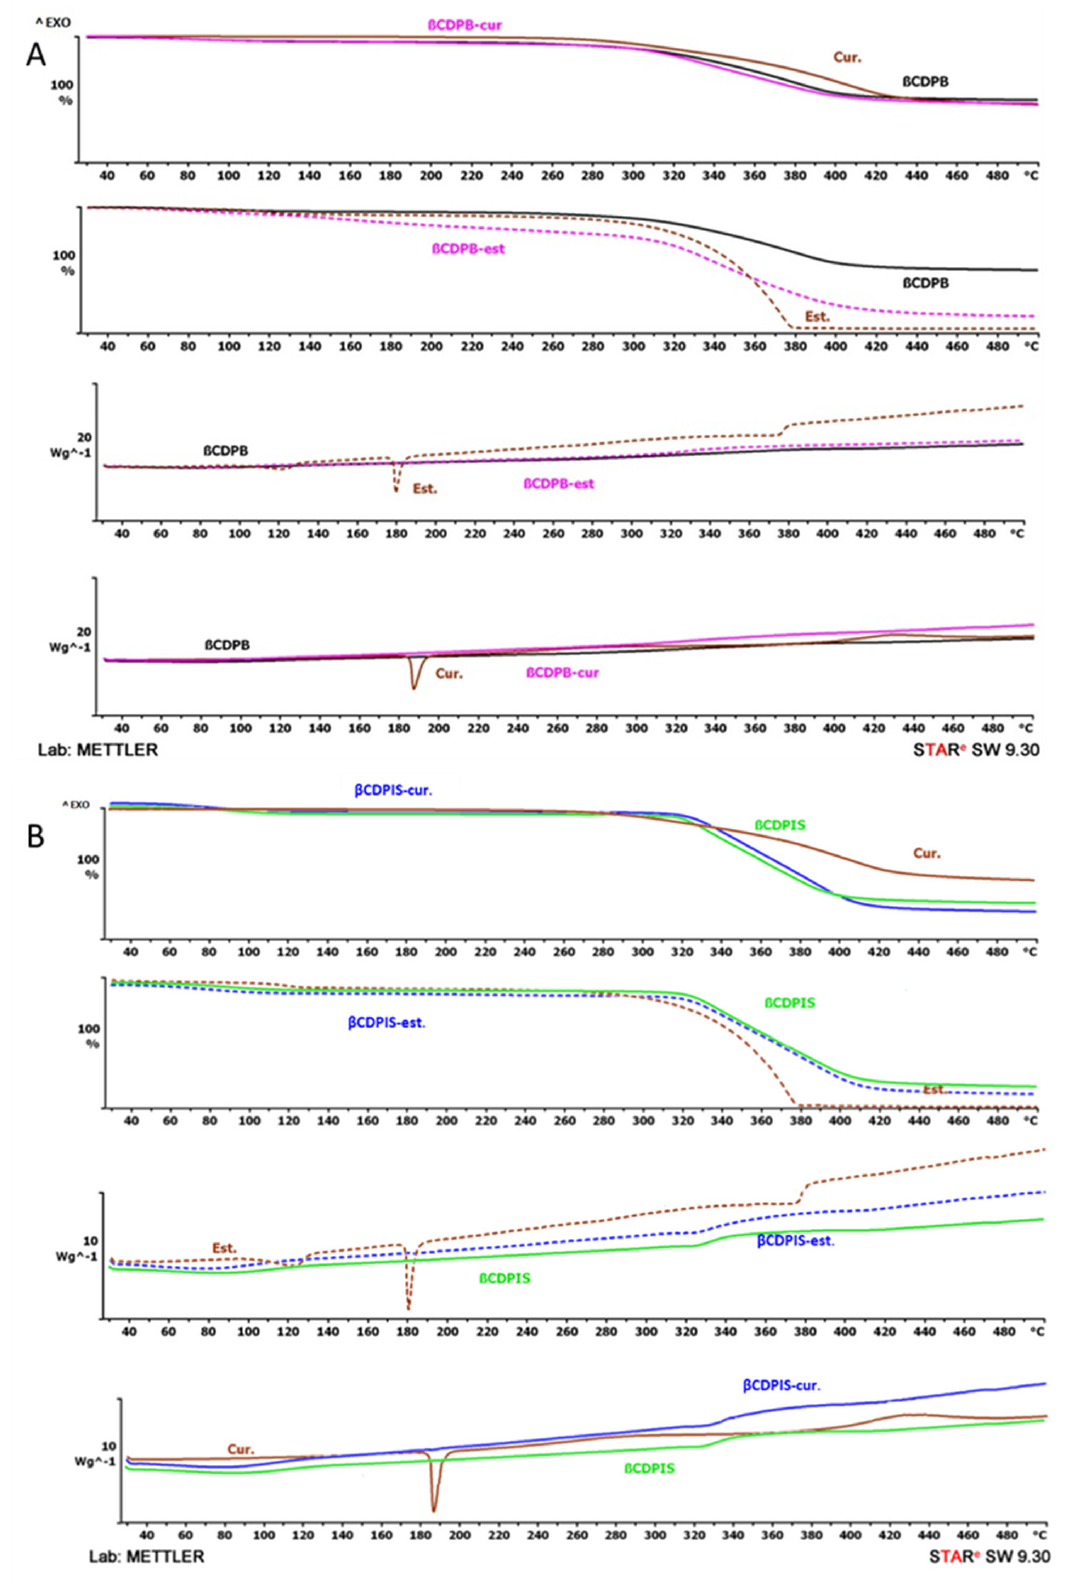
Figure 8. TGA (upper two sections of subfigures A and B) and DSC (lower two sections of figures A and B) analysis of native polymers, APIs and their inclusion complexes with β CDPB ( A ) and β CDPIS ( B ).